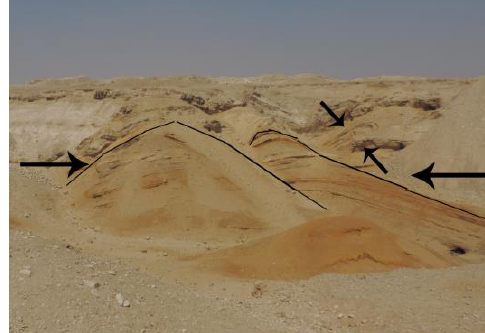
Figure 5: Symmetrical and unsymmetrical folds Varieties of folds are obvious (symmetrical and unsymmetrical folds) appear in this area.